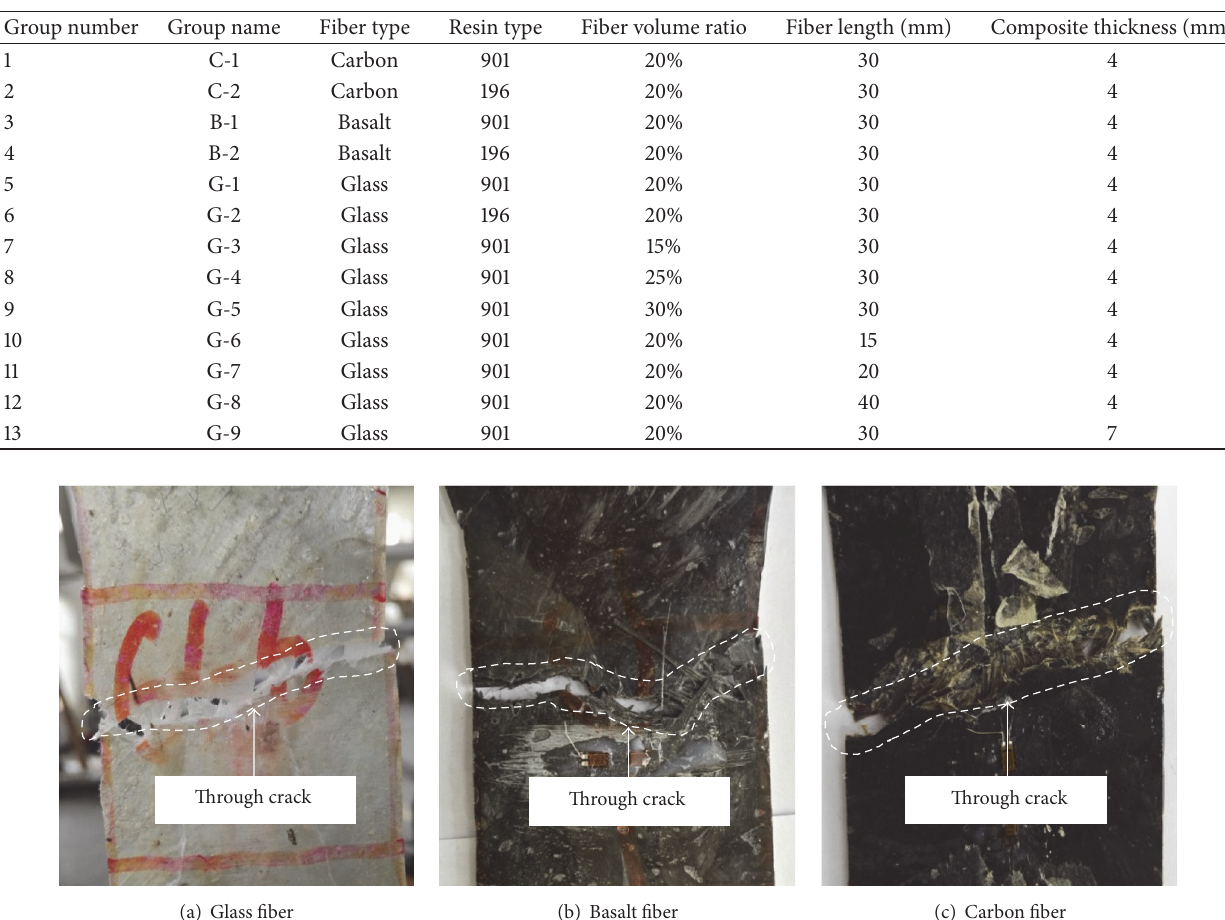
Table 3: Specimen plan.